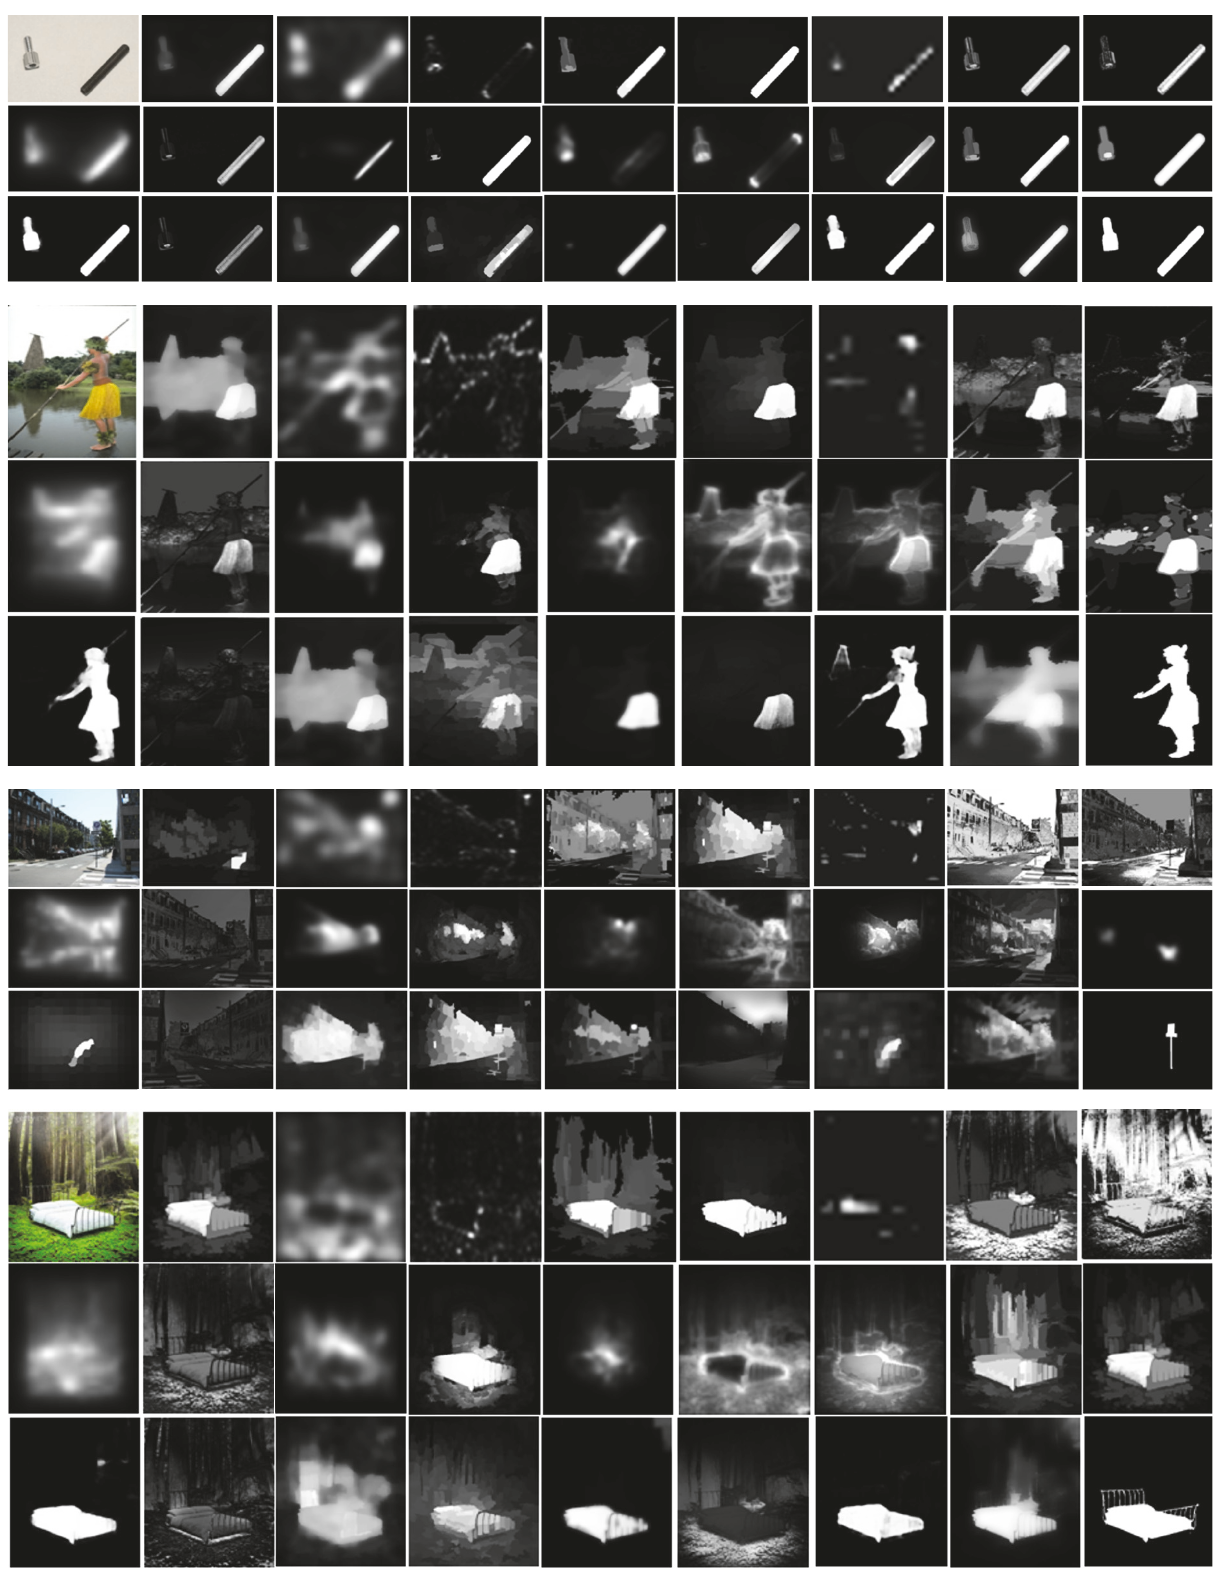
Figure 3: Saliency map (left to right: original image, RBD, SS, SR, RC, MC, IT, HC, GC, GB, FT, FES, DSR, COV, CA, PCA, DRFI, Stru, AM, AC, BL, LS, MAP, SF, UCF, MS, and GT. Top to down: SED2, ECSSD, JuddDB, and